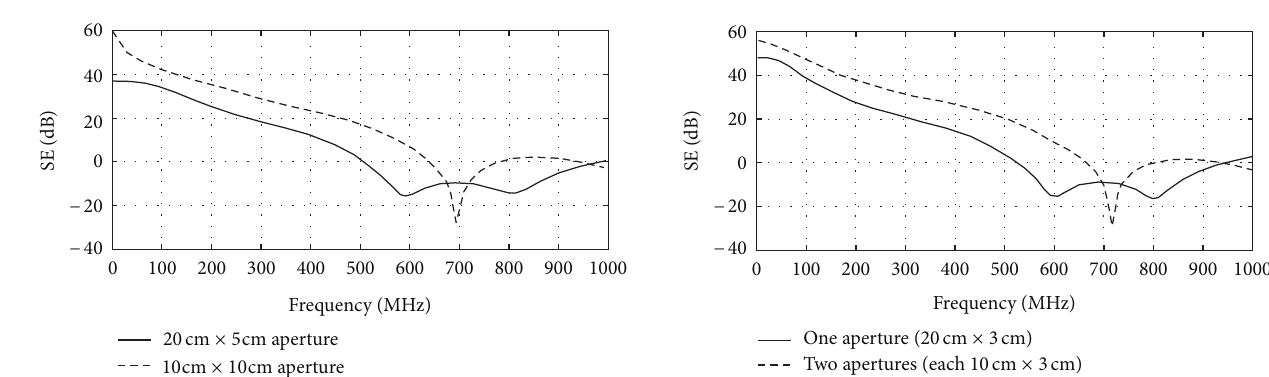
One aperture ( 20 cm × 3 cm) Two apertures (each 10 cm × 3 cm)